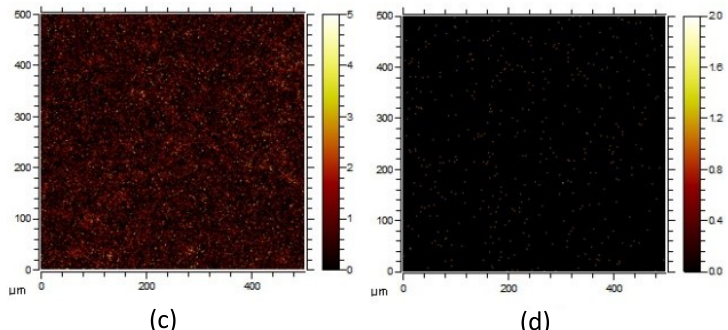
Figure 3. Two-dimensional distributions of ions on the fluorapatite (FA) surface (500 × 500 µm 2 ) treated with H 2 SO 4 (1 × 10 −3 mol/L): ( a ) overlap, ( b ) PO 3− , ( c ) SO 4− , and ( d ) CaO − .